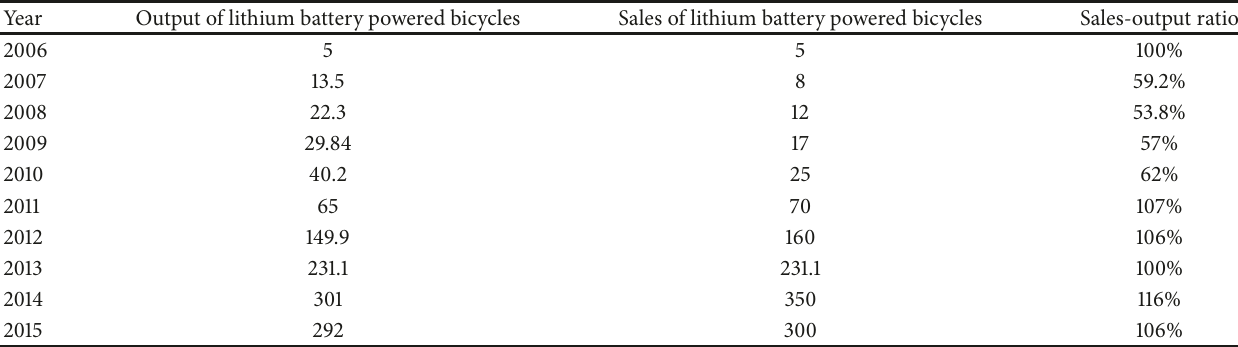
Table 4: Sales-output ratio of lithium battery powered bicycles in 2006-2015 (unit: 10,000 sets).